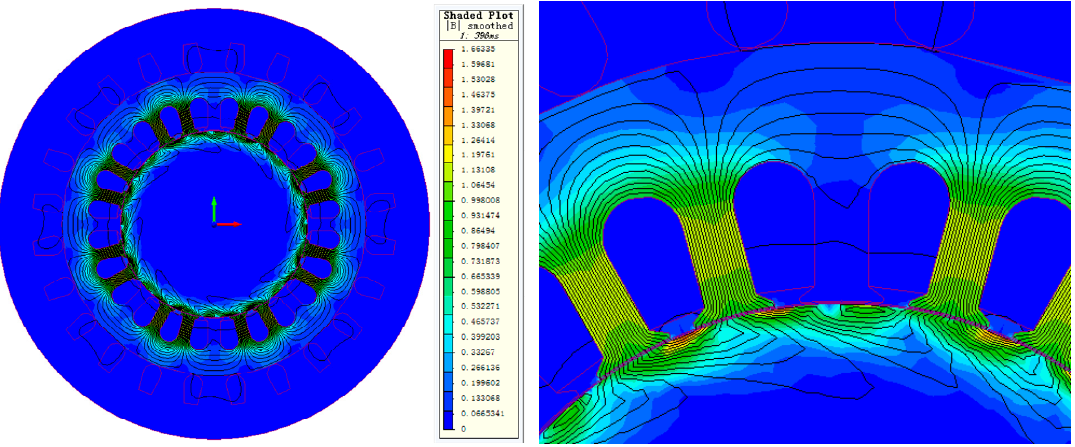
Figure 8. 2D non-copper plating model of the N-TWSRIM.